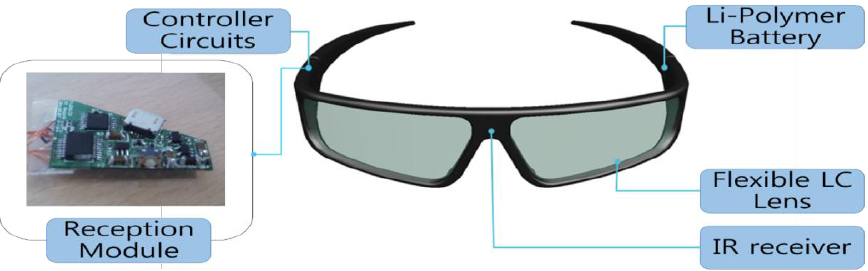
Figure 8. The prototype of the active shutter glasses with the flexible liquid crystal lens.